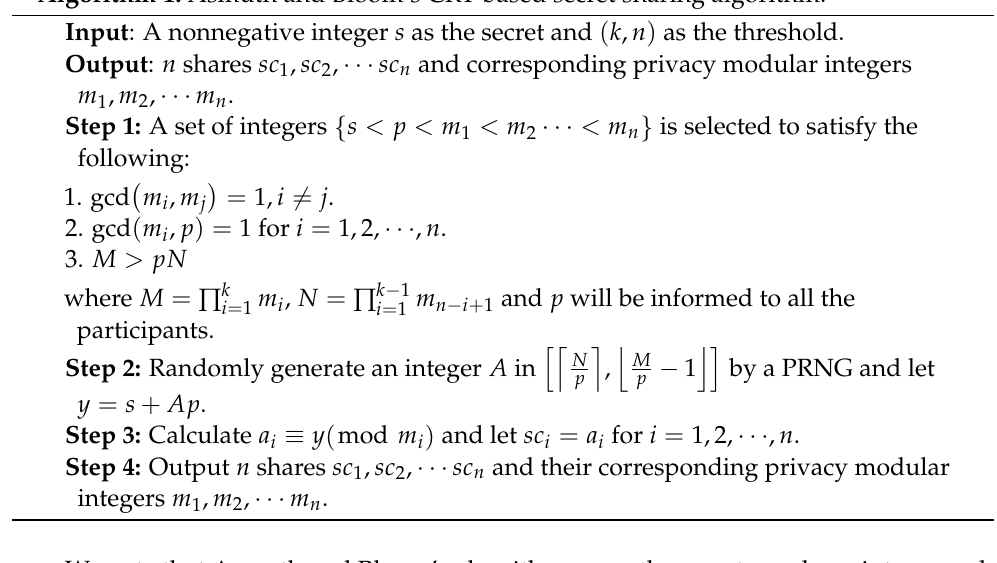
Algorithm 1: Asmuth and Bloom’s CRT-based secret sharing